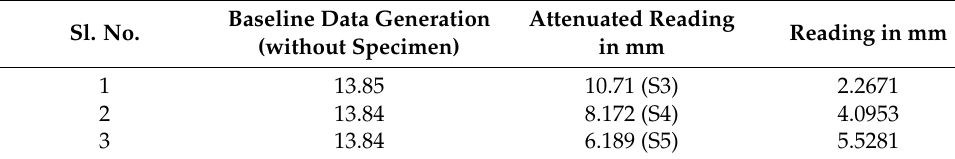
Table 3. Estimated gamma attenuation levels.